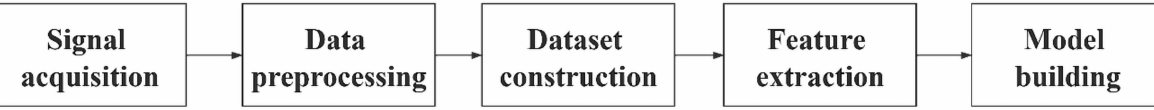
Figure 6. Block diagram of the construction procedure of SP-based emotion recognition